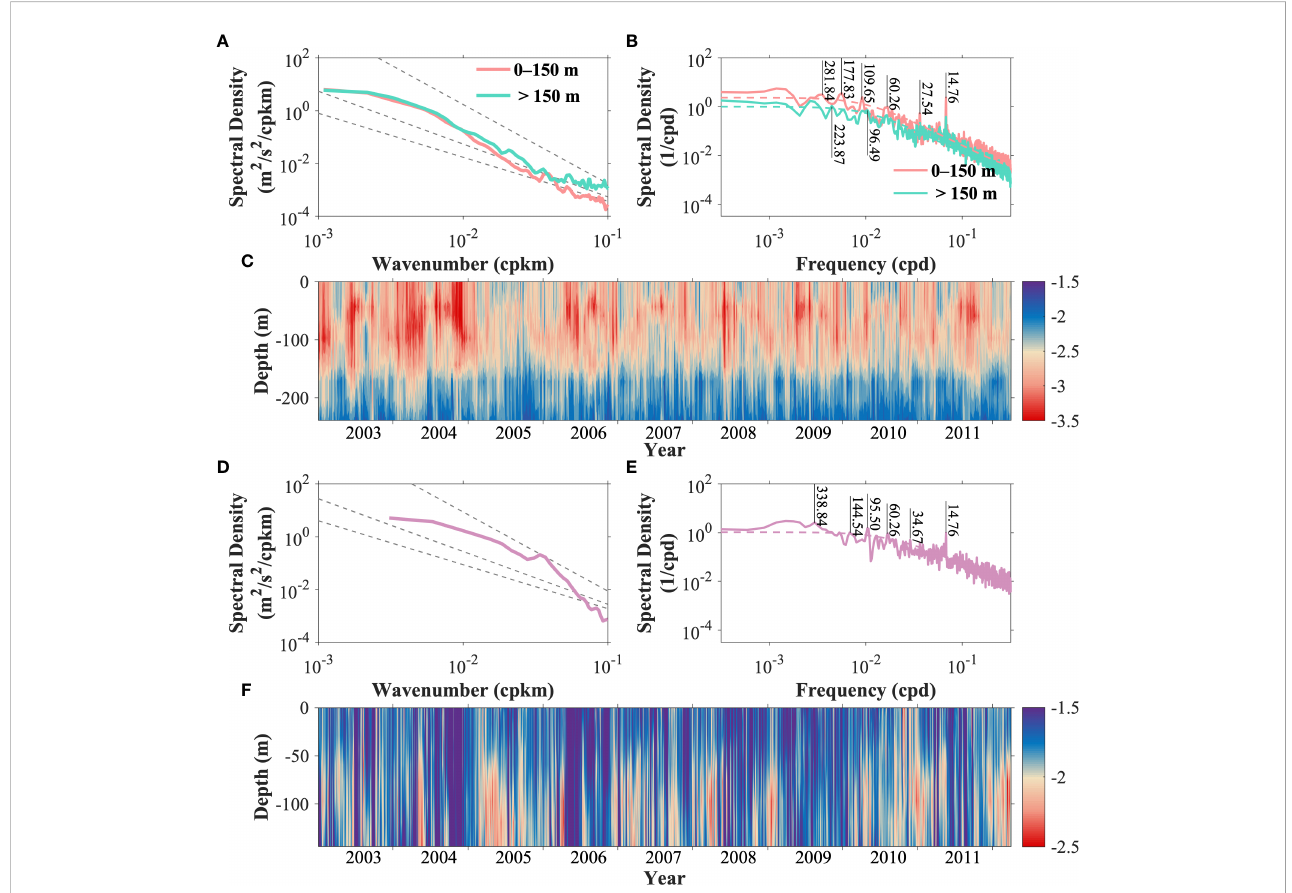
FIGURE 6 (A) Kinetic energy wavenumber spectra along the Kuroshio axis, averaged between 2003 and 2012. Spectra of layers above (pink) and below (green) 150 m were separately vertically averaged. Power laws of k − 5/3 , k − 2 , and k − 3 were presented by gray dashed lines. (B) Frequency spectra of linearly fi tted slopes of wavenumber spectra for scales larger than 20 km (~10 − 1.3 cpkm). They were calculated for each layer and separately averaged above (pink) and below (green) 150 m. Colored dashed lines were at the 95% signi fi cance level estimated by the red noise spectrum. (C) Time series of linearly fi tted slopes of wavenumber spectra. Some typical spectral peaks were marked by corresponding periods. (D – F) Same as (A – C) , respectively, but for sections across the Kuroshio in the Tokara Strait (Figure 1C) and were not averaged separately for the upper and lower layers. The (F) had a shallower depth range than the (C) because the data sampling was not continuous after being in fl uenced by underwater seamounts in the